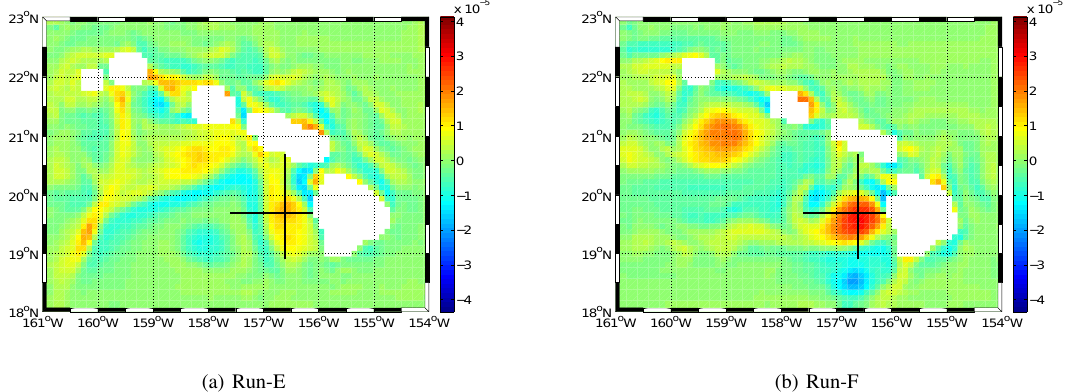
Fig. 11. Relative vorticity field at 40-m depth with position of the transects (black straight line) of the eddy C5-E (Run-E, 13 April, left) and of the eddy C1-F (Run-F, 28 March, right).